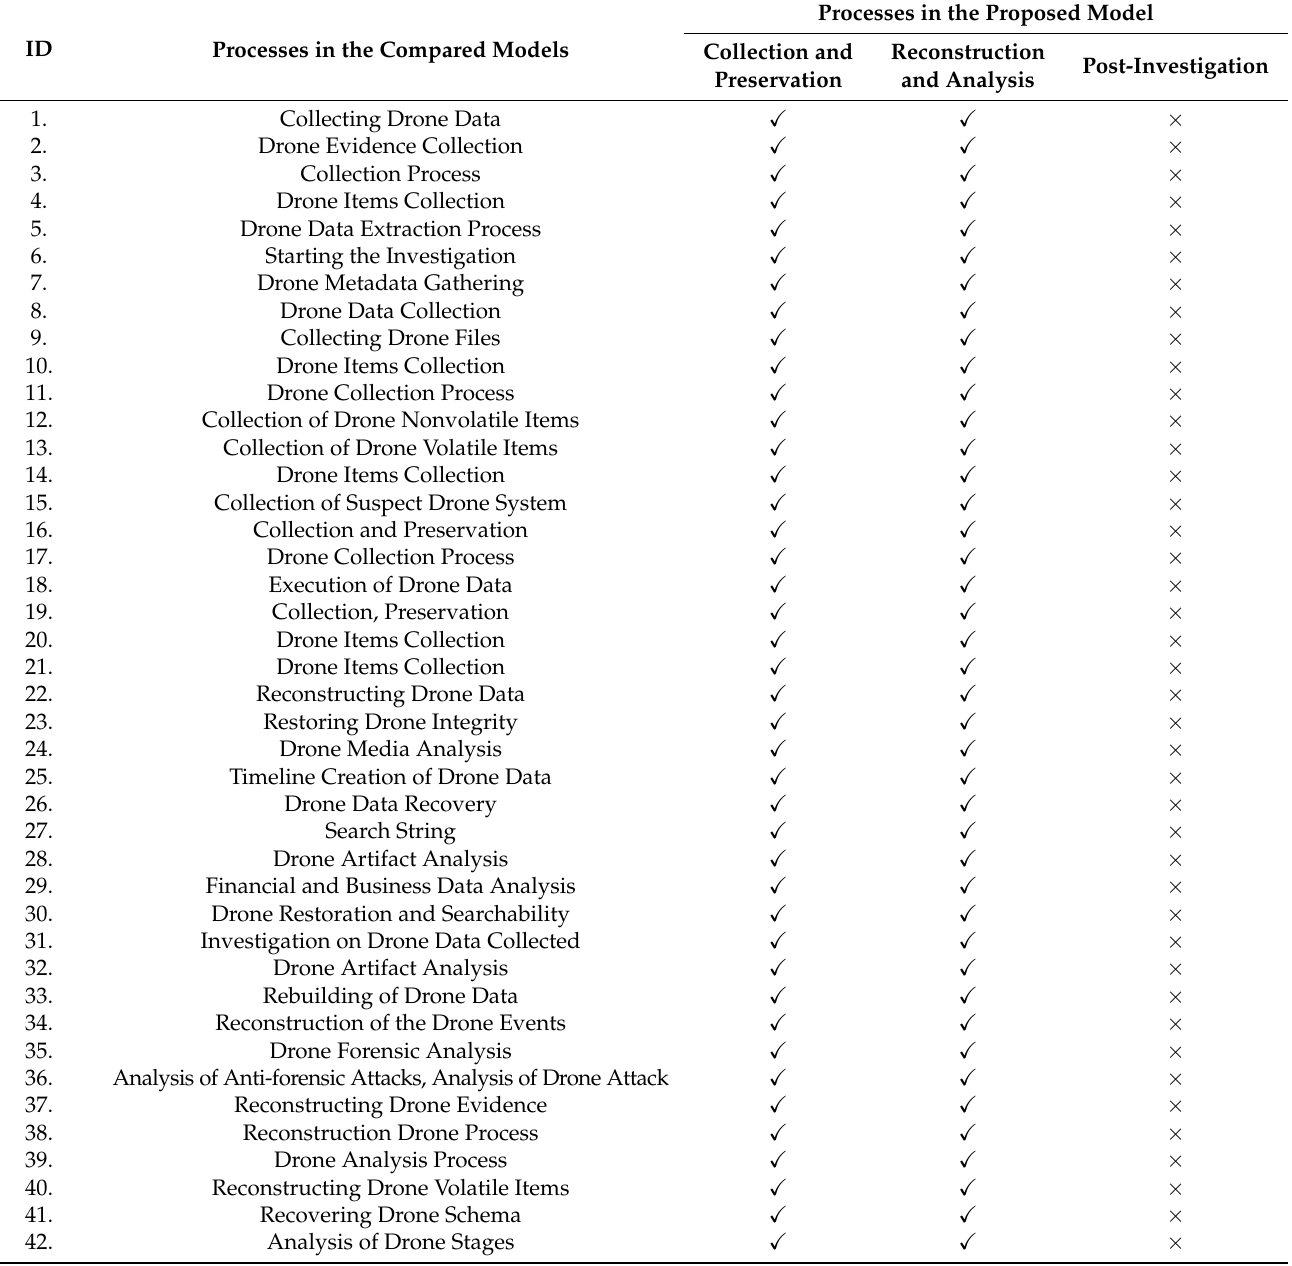
Table 5. A comparative summary: the proposed CCAFM and existing drone forensic